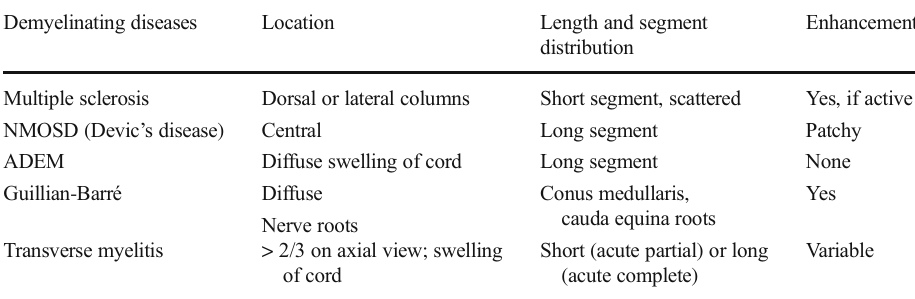
Table 1 Demyelinating disease summary